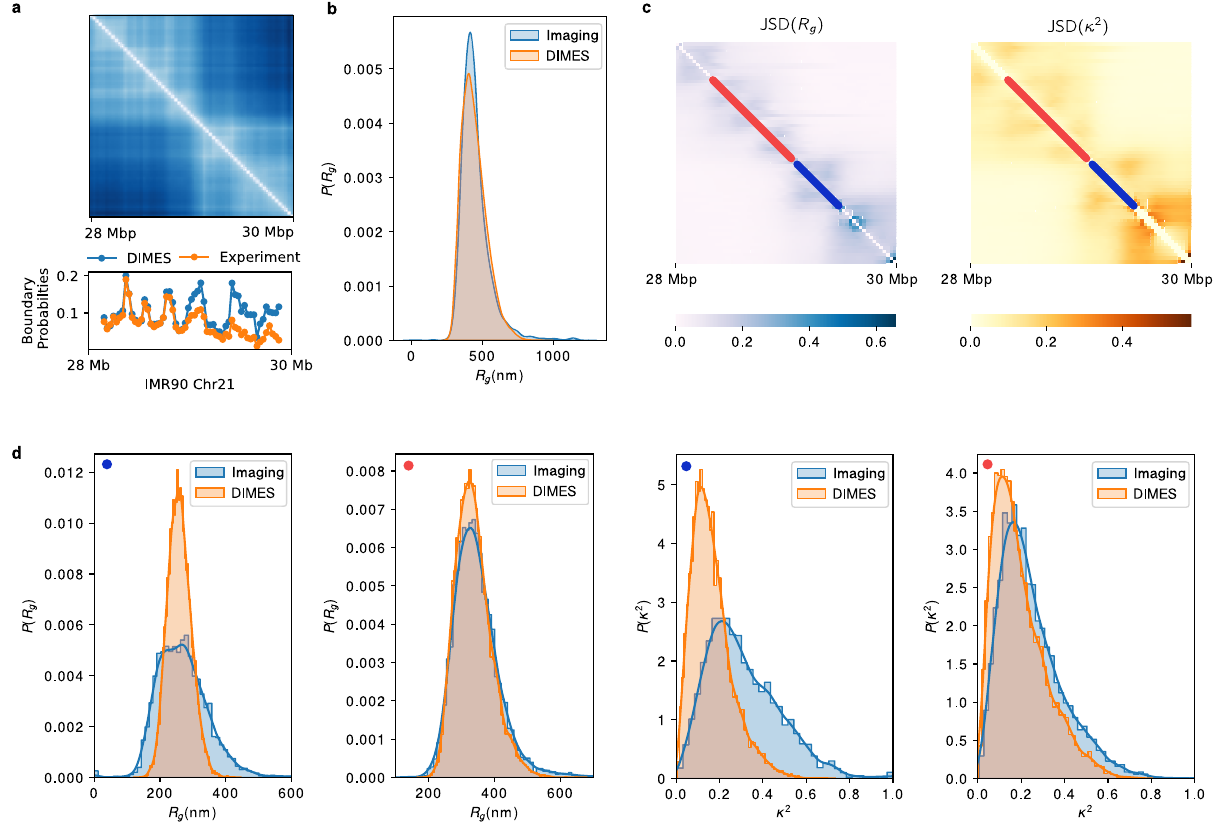
Fig. 5 | TAD-like structures and shape characteristics of Chromosome 21. a Comparison of boundary probabilities between experimental imaging data and prediction from DIMES. Boundary probability measures the probability that a genomic locus acts as a single-cell domain boundary. b Comparison of P ( R g ) betweentheexperimentandtheDIMESpredictions. P ( R g )istheprobabilitydensity distribution of the radius of gyration R g for the 28 – 30 Mbp region of Chr21. Comparison of P ( κ 2 ) where κ 2 is the shape parameter is shown in Supplementary